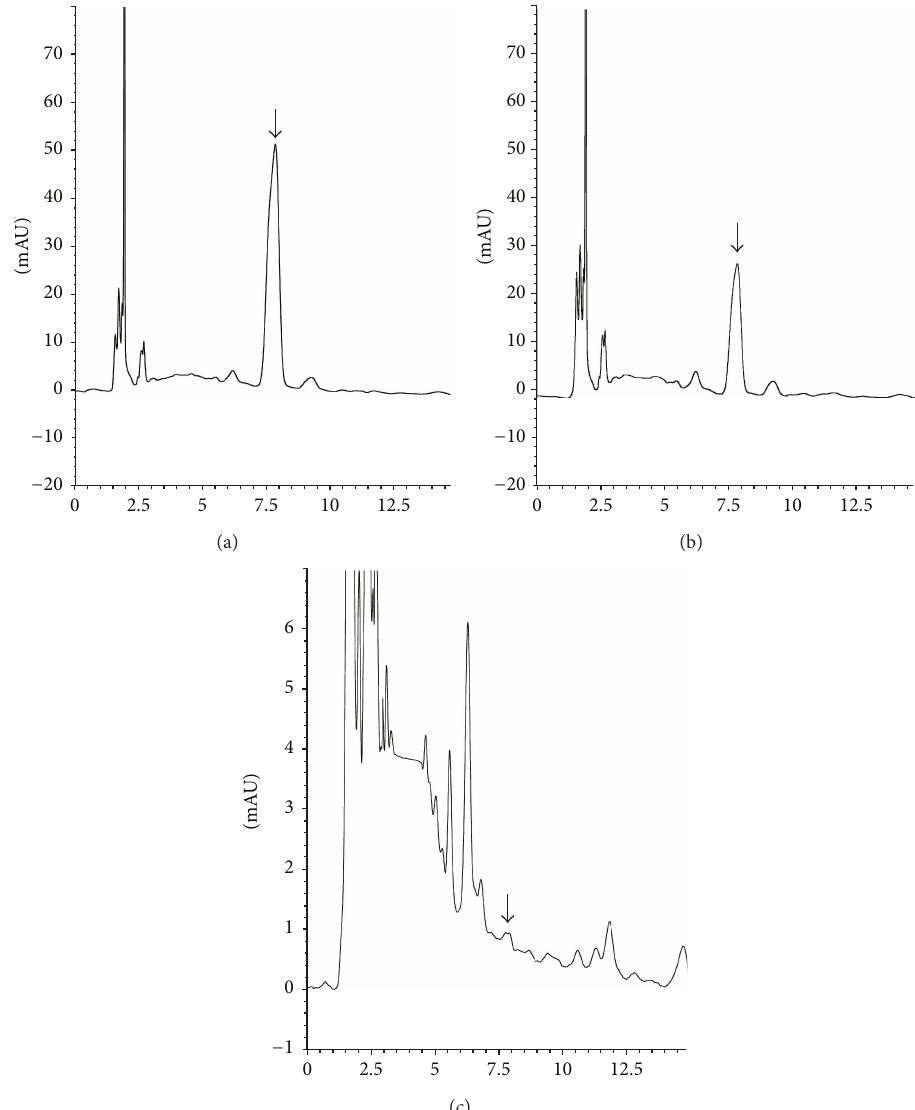
Figure 3: Chromatogram at 270 nm of the extract from Antidesma thwaitesianum by (a) supercritical carbon dioxide, (b) ethanol, and (c) water extraction. Arrow indicates catechin peak at retention time 7.84